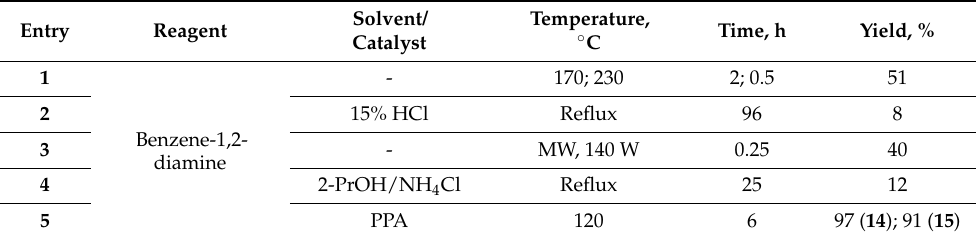
Table 1. Reaction conditions for the synthesis of benzimidazoles 14 and 15 and their corresponding product